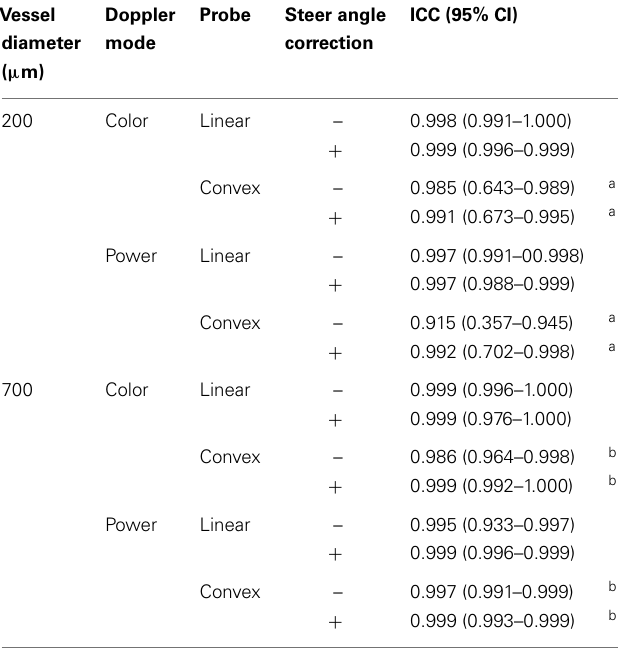
Table 2 | Reproducibility of velocity measurements